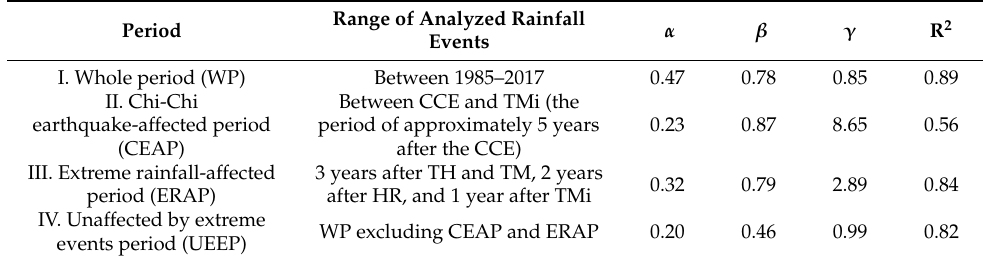
Table 2. Empirical coefficients α , β , and, γ of Equation (6) during the four periods.